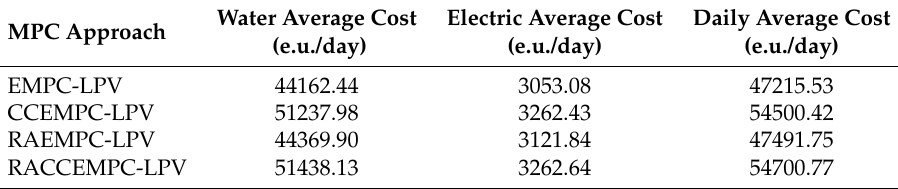
Table 5. Comparison of daily average costs of the MPC